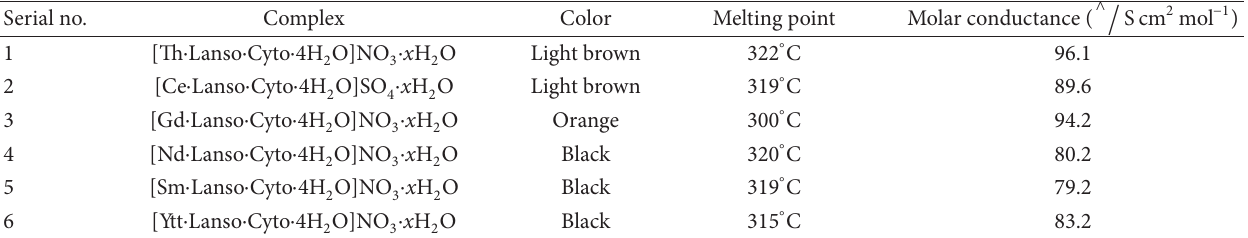
T 3: Analytical data of synthesized mixed ligand complexes of M-Lanso-Cyto.